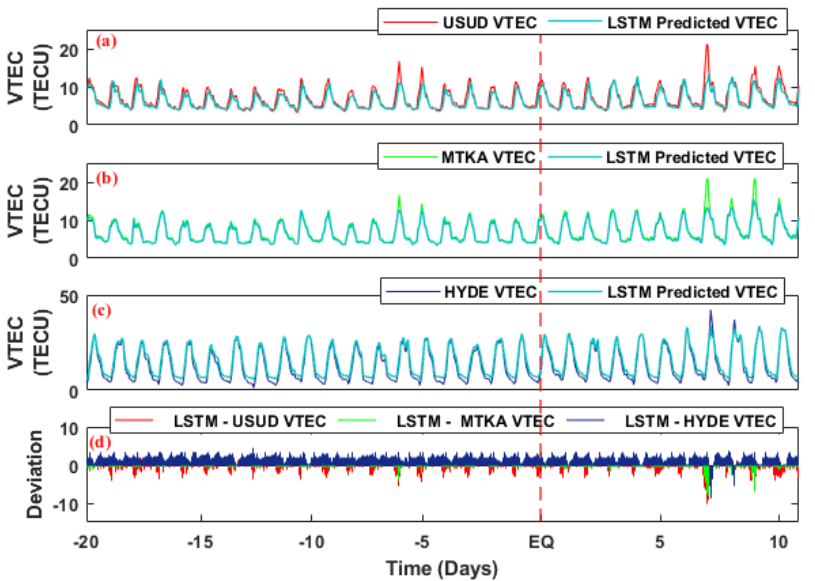
Figure 12. ( a ) Variation of USUD VTEC with LSTM train VTEC, ( b ) Time series variation of MTKA VTEC with LSTM-predicted VTEC, ( c ) Variation of HYDE VTEC with LSTM-predicted VTEC, ( d ) Deviation of LSTM train VTEC from USUD, MTKA, and HYDE VTEC. The red dashed line shows earthquake day. Table 1. The anomalies detected using statistical method. Parameters